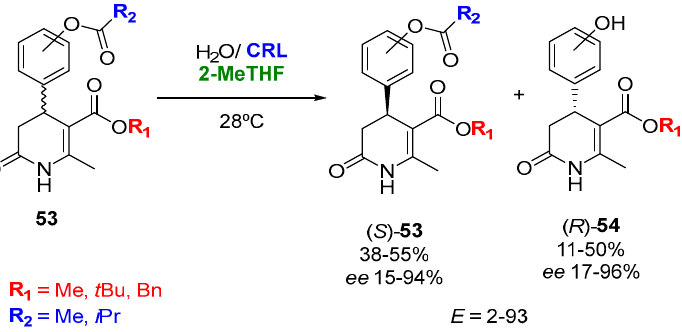
Figure 28. Lipase-catalyzed preparation of several 3,4-DHP-2-ones in water/2-MeTHF.